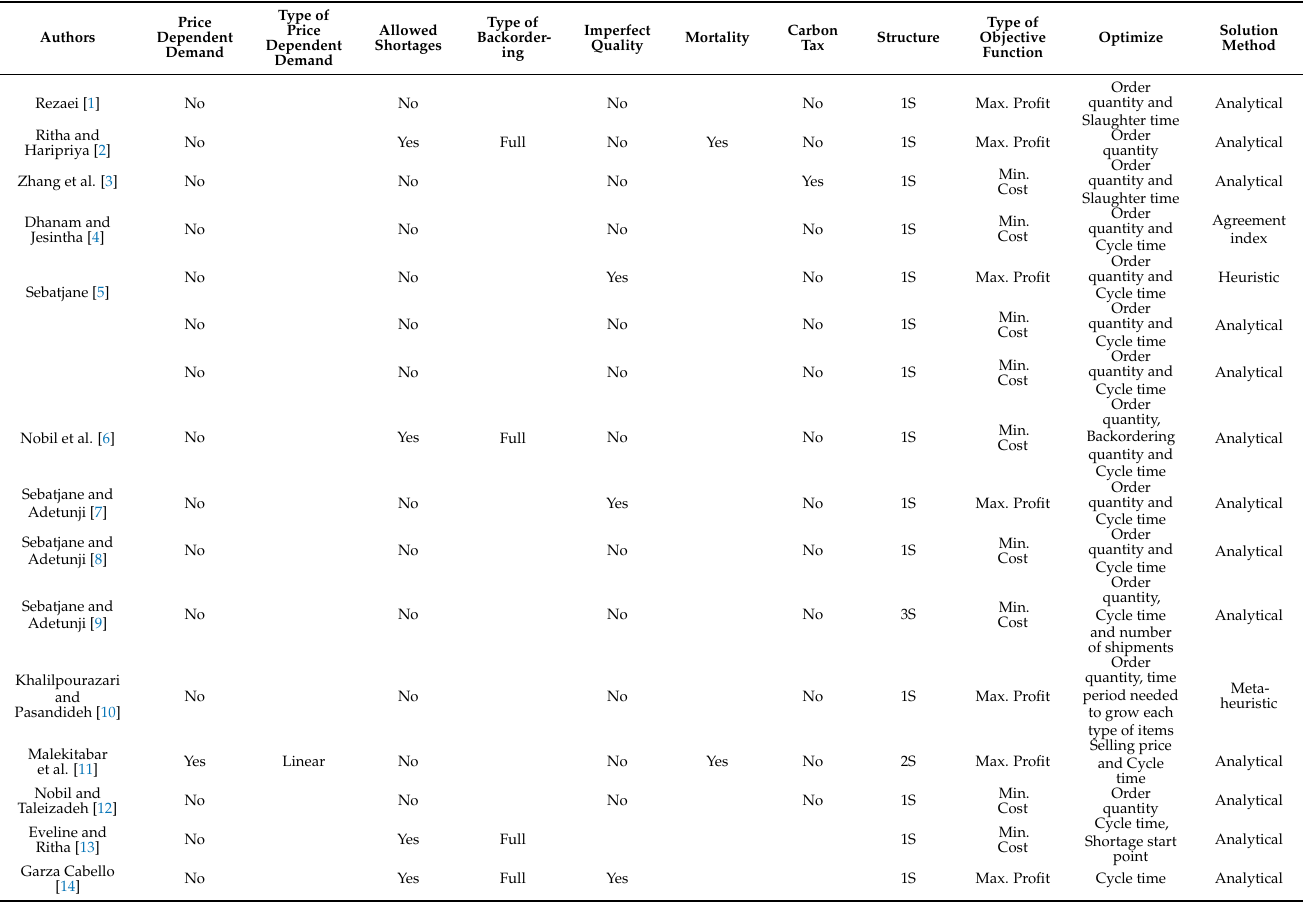
Table 1. Inventory models with growing